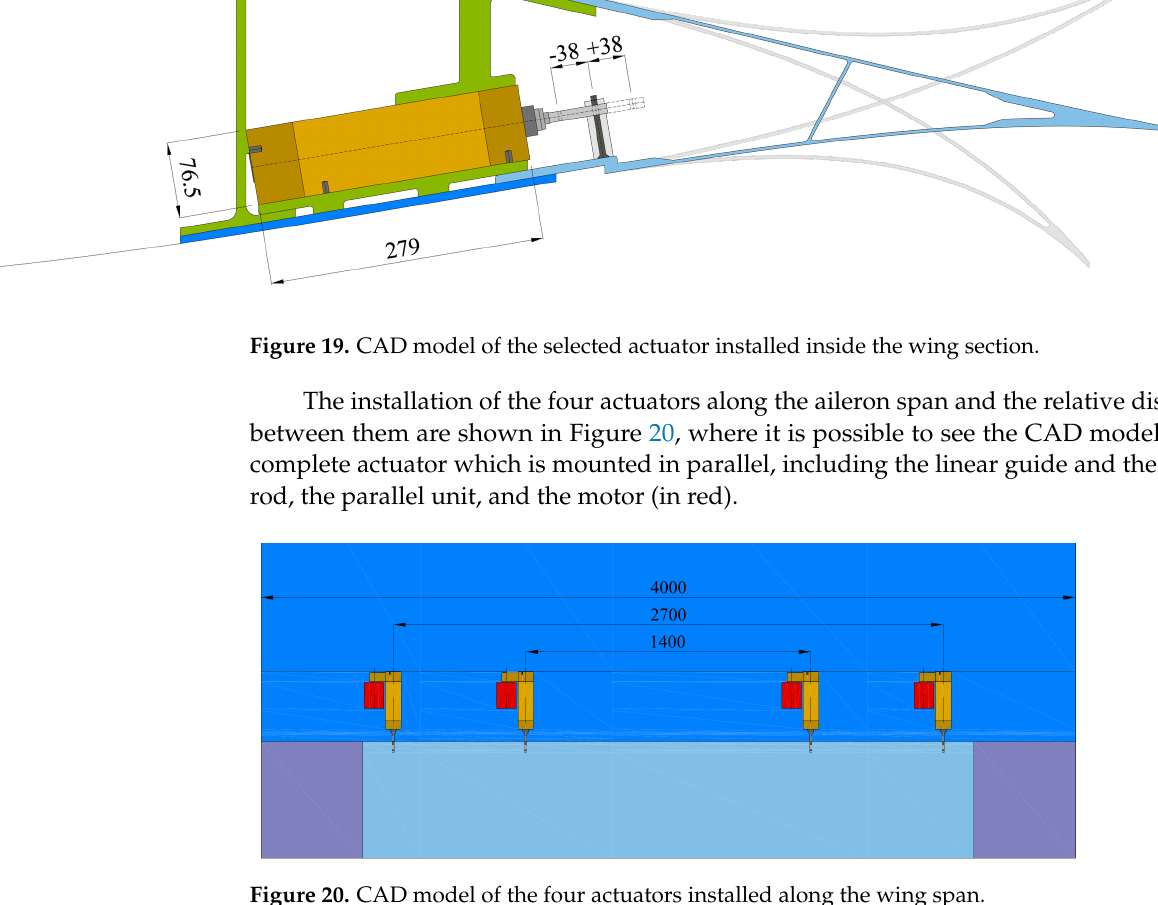
Figure 20. CAD model of the four actuators installed along the wing